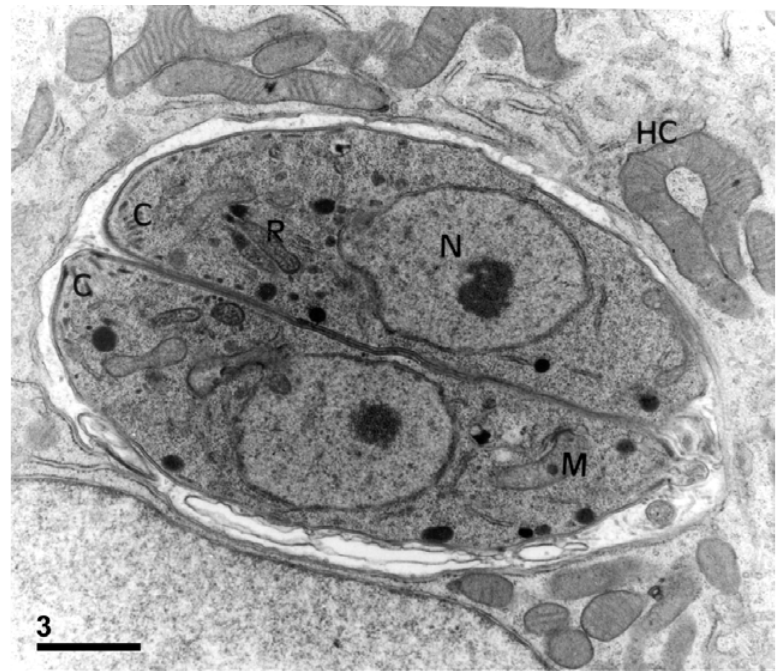
Fig. 3 – Two trophozoites of Toxoplasma gondii within the parasitophorous vacuole. C, conoid; HC, host cell; M, mitochondrion; N, nucleus; R, rhoptries. Bar, 0.4 µ